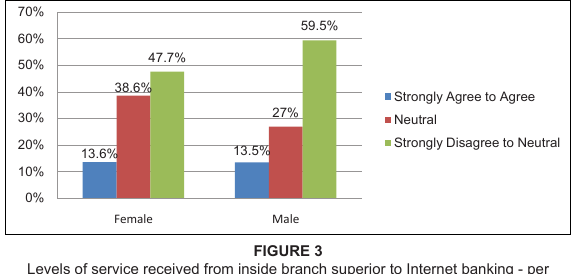
Levels of service received from inside branch superior to Internet banking - per